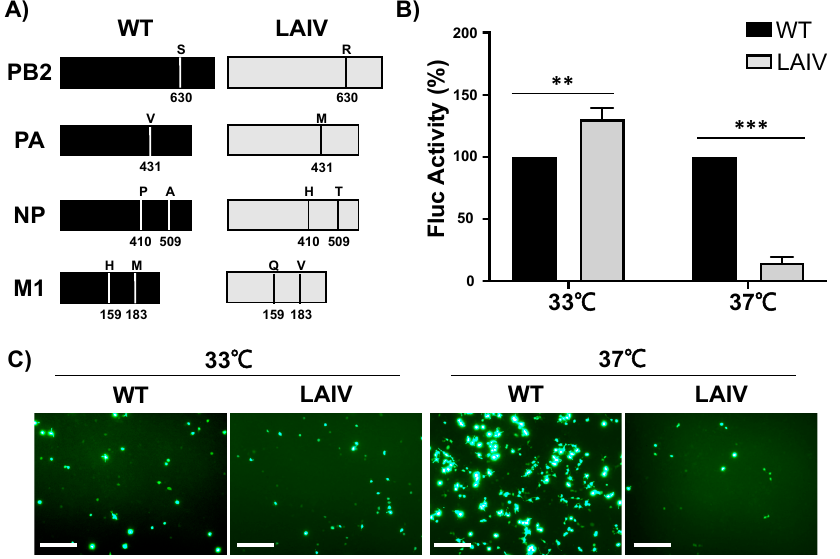
Figure 1. Influenza B/Ann Arbor/1/1966 MDV LAIV mutations confer a ts and ca phenotype to the polymerase and NP of B/Brisbane/60/2008. ( A ) Schematic representation of the PB2, PA, NP, and M1 viral proteins of B/Brisbane/60/2008 WT (left) and MDV LAIV (right): Six of the seven mutations responsible for the ts, ca and att phenotype of B/Ann Arbor/1/1966 MDV LAIV (NP mutation V114A was already present in B/Brisbane/60/2008 WT) were introduced into the PB2, PA, NP and M1 proteins to generate the B/Brisbane/60/2008 MDV LAIV. ( B , C ) Minigenome activity: Human 293T cells were transfected with 500 ng of pDP expression plasmids encoding the four proteins required for IBV replication and transcription (pDP-PB2, pDP-PB1, pDP-PA and pDP-NP) together with minigenome plasmids encoding Fluc or GFP flanked by IBV non-coding regions under the control of the human polymerase I promoter, and a SV40-driven polymerase II promoter Renilla luciferase (Rluc) expression plasmid to normalize transfection efficiencies. After 6 h transfection, cells were placed at either 33 or 37 ◦ C. Viral genome replication and gene transcription were determined at 48 h post-transfection by Fluc (B) and GFP (C) expression. WT FLuc/Rluc expression level was normalized to 100% and LAIV Fluc/Rluc expression calculated relative to WT. Data is represented as the mean and SD. Student t test was performed to determine p values. **, p < 0.01; ***, p < 0.001. Representative images of GFP expression by WT or MDV LAIV B/Brisbane/60/2008 polymerases and NPs at the indicated temperatures are shown. Scale bars = 100 µ